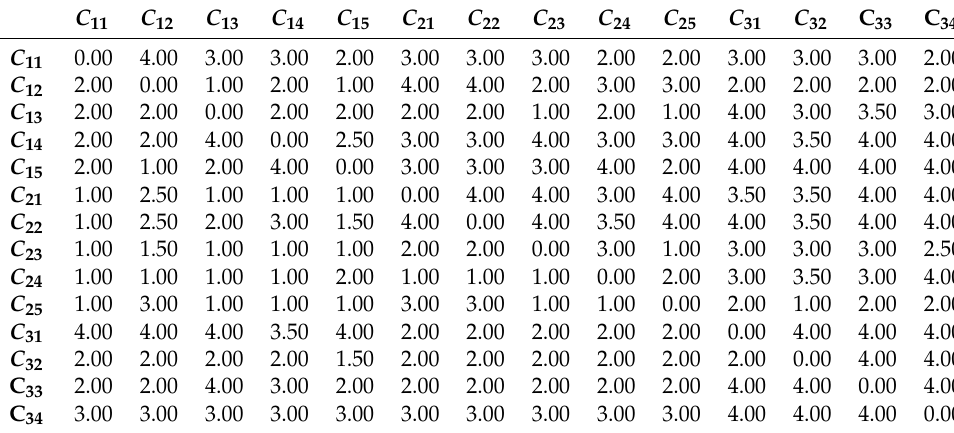
Table 3. Initial average matrix A I